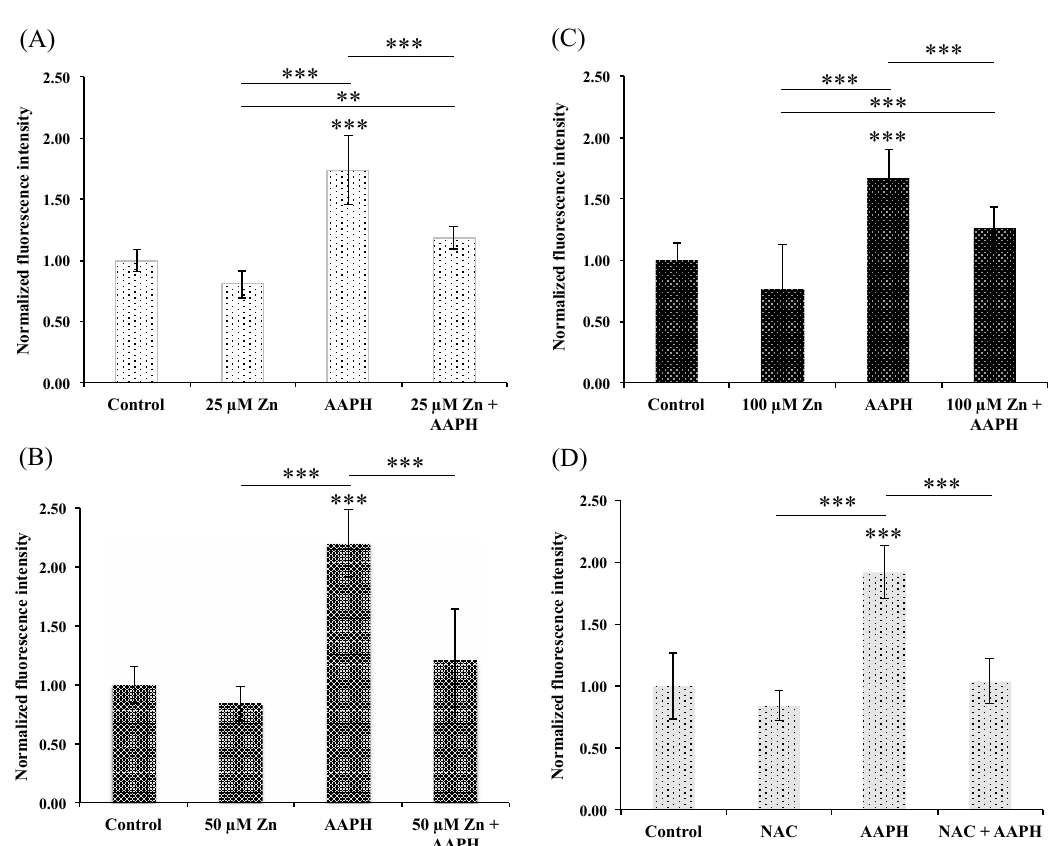
Figure 2. Histograms showing normalized fluorescence intensity of DCF-DA probe in different treatment groups of cells analyzed by a fluorescent plate reader. HRPEsv cells were either: i) non-treated (see control bar in panels A , B , C and D ); ii) treated with AAPH (5 mM for 1 h, see AAPH bar in panels A , B , C and D ); iii) treated with 25, 50, 100 μ M of zinc alone for 24 h (see Zn bar in panels, A , B , and C ) or with 10 mM of NAC alone for 24 h (see NAC bar in panels D ); or iv) pre-treated for 24 h with 25, 50, 100 μ M of zinc or 10 mM of NAC, followed with a treatment with